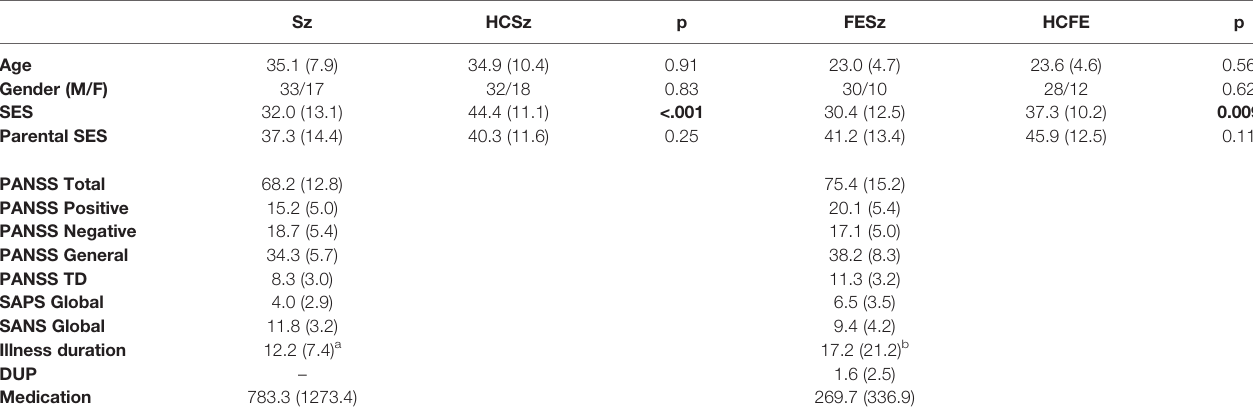
TABLE 1 | Demographic and clinical